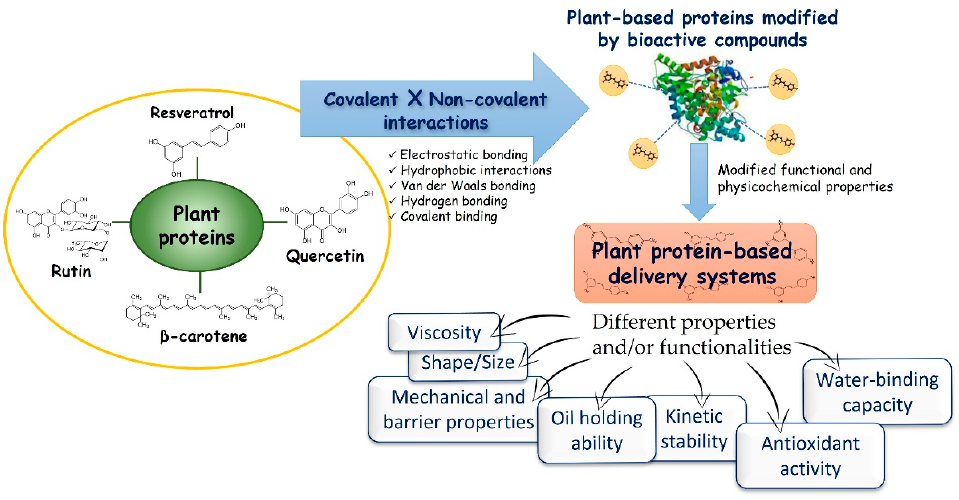
Figure 4. Interactions between proteins and lipophilic bioactive compounds and their effects on plant-based protein structure and characteristics of plant protein-based carrier platforms.